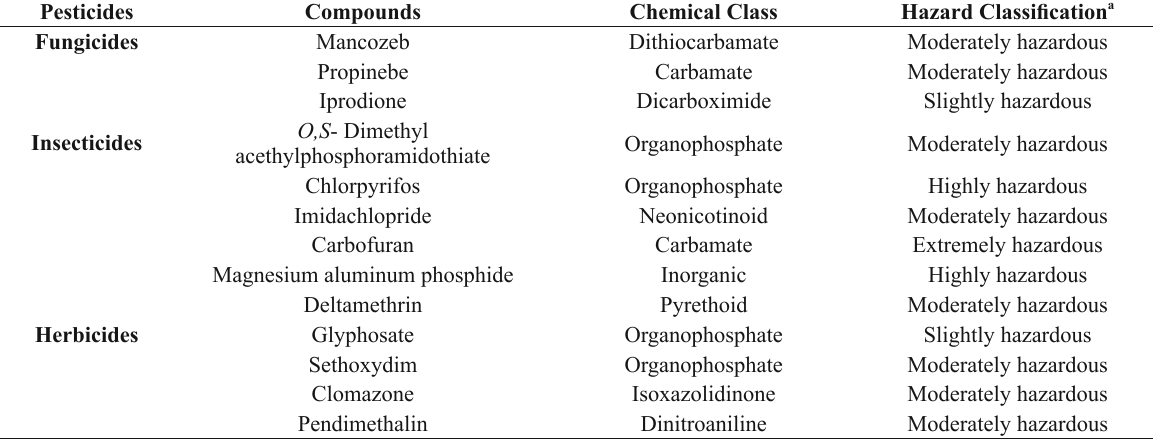
List of pesticides used by exposed group in tobacco